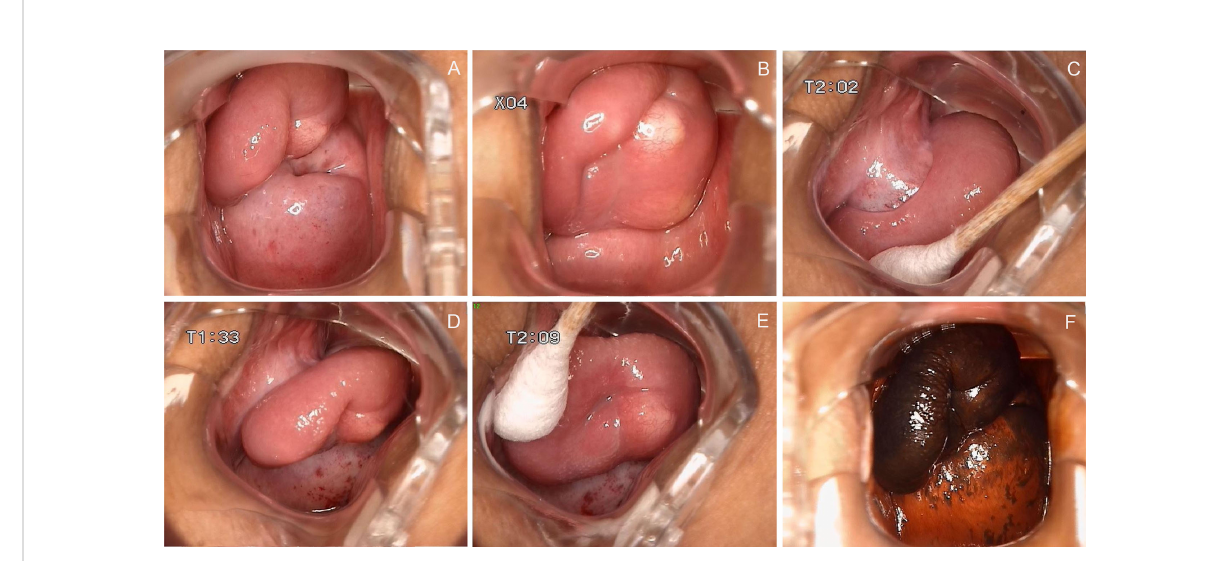
FIGURE 2 Colposcopy fi ndings of the patient. (A – C) A mass was observed on the right anterior wall of the upper part of the vagina, approximately 3.0 cm × 3.0 cm × 1.0 cm in size, pink, tough in texture, smooth on the surface, small vesicles visible inside the mass, a wide pedicle connected to the vaginal wall, and the shape similar to a mushroom; (D, E) There was no signi fi cant change in the tumor epithelium after staining with 5% acetic acid; (F) The tumor epithelium appeared brownish-black after staining with 5% Lugol ’ s